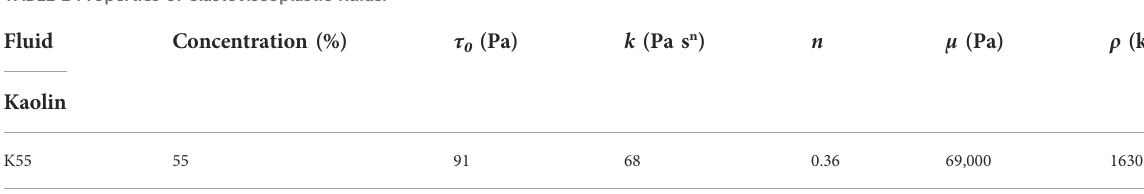
TABLE 1 Properties of elastoviscoplastic fl uids.